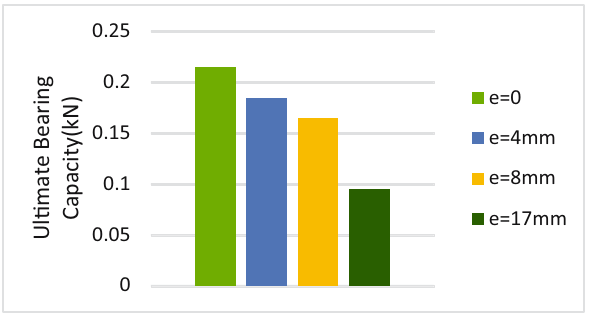
Figure 13: Ultimate bearing load at D s = 0.